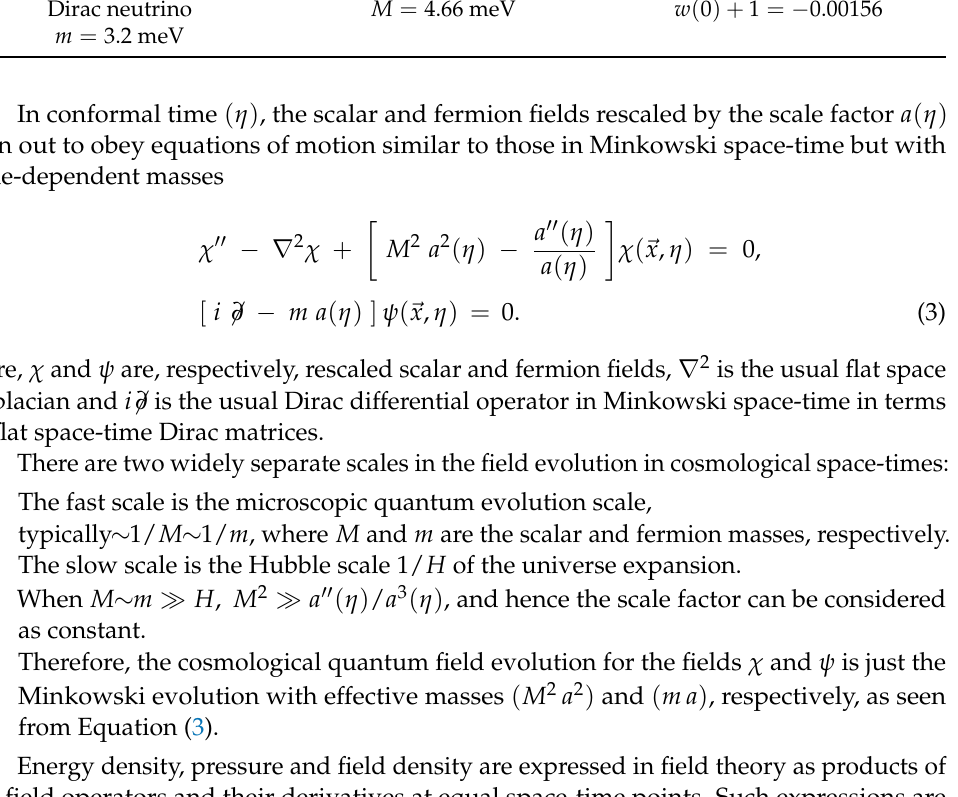
Table 1. The Equation of state today, w(0) + 1, computed from Equation (80) in three relevant cases, which all describe the dark energy observed today (Equation (89)): (i) no neutrino contribution to the dark energy; (ii) a Majorana neutrino contribution with mass m = 3.2 meV; (iii) a Dirac neutrino contribution with mass m = 3.2 meV. See the discussion in Section 9. Neutrino Type Scalar Mass Equation of State Today No vacuum neutrino energy M = 3.96 meV w ( 0 ) + 1 = − 0.00794 Majorana neutrino M = 4.35 meV w ( 0 ) + 1 = − 0.00473 m = 3.2 meV Dirac neutrino M = 4.66 meV w ( 0 ) + 1 = − 0.00156 m = 3.2